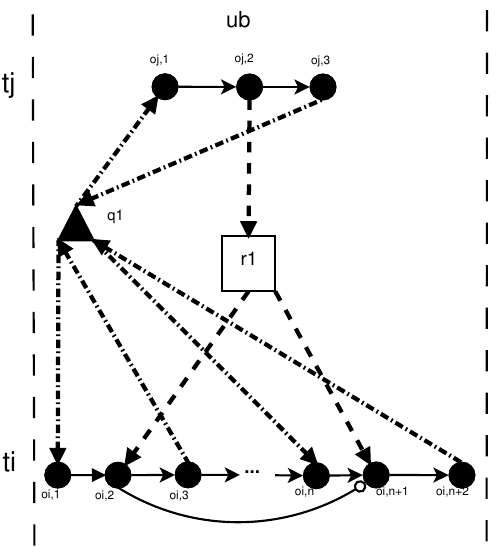
Figure 7. Subgraph showing the first scenario of atomicity